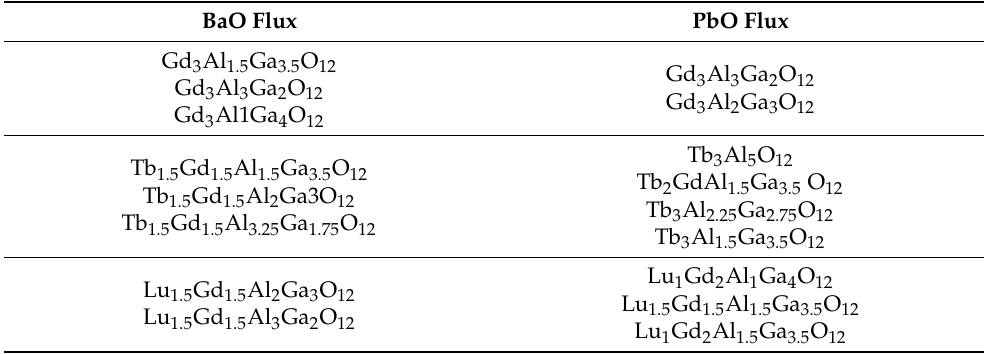
Table 1. Nominal contents of rare earth cations in the studied films grown from different